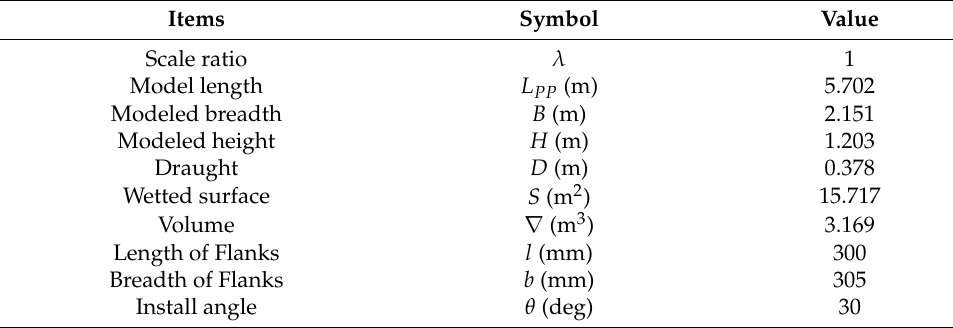
Table 1. Main geometric parameters of the vehicle model.